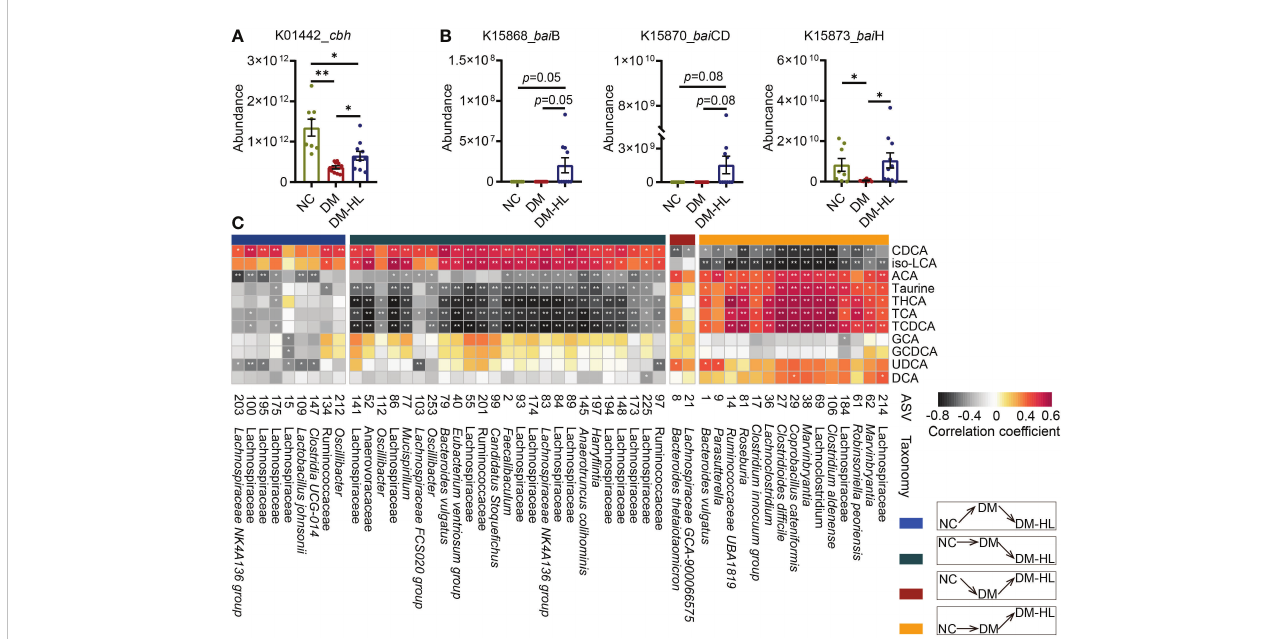
FIGURE 5 Alteration of BA composition was related to that in the gut microbiota. (A) The absolute abundance of the cbh gene predicted by PICRUSt2. (B) The absolute abundance of the bai B, bai CD, and bai H genes predicted by PICRUSt2. (C) The Spearman correlation between metabolites and microbes. ASVs belong to different classi fi cations based on their inconsistent responses to HFD/STZ treatment and HL administration. The metabolites were involved in microbial bile acid metabolism in the gut. The color of the block indicates the correlation (red = positive, black = negative). The corrected p value was adjusted by FDR. * p < 0.05; ** p < 0.01. For graph (A, B) , data are presented as the mean ± SEM, and signi fi cance was evaluated by an unpaired t test with Welch ’ s correction. * p < 0.05, ** p <